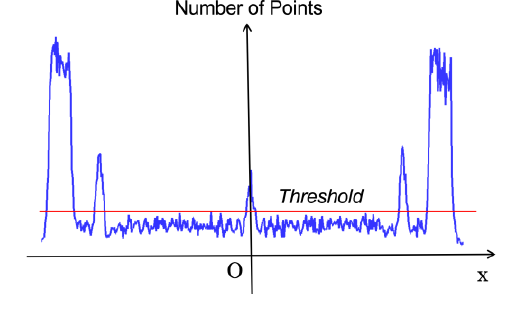
Figure 14. Histogram of points